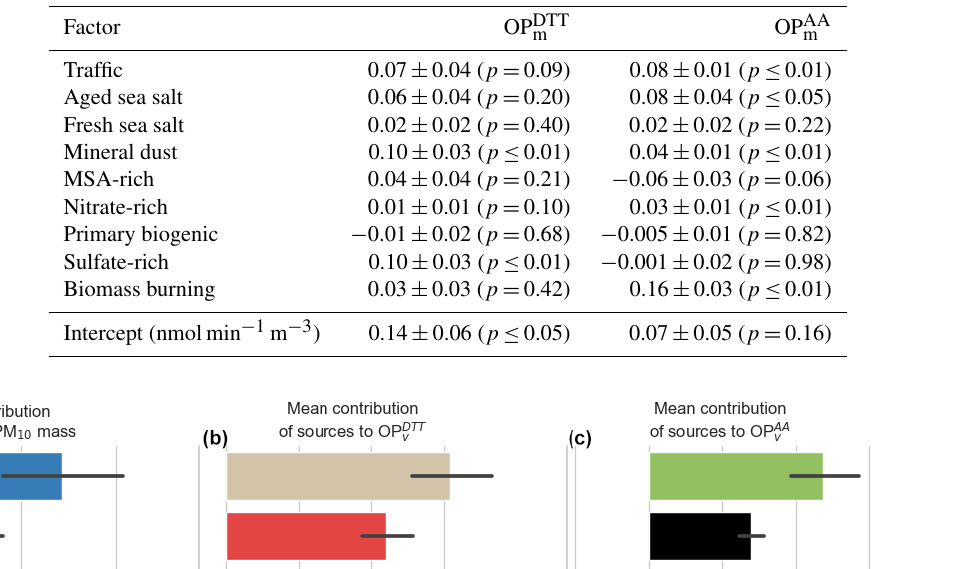
Table 2. Regression coefficients (i.e. intrinsic OP or OP m , expressed in nmolmin − 1 µg − 1 ) at the OPE site for the DTT and AA assays. The values are the mean ± standard deviation, and the p value is in the parentheses.